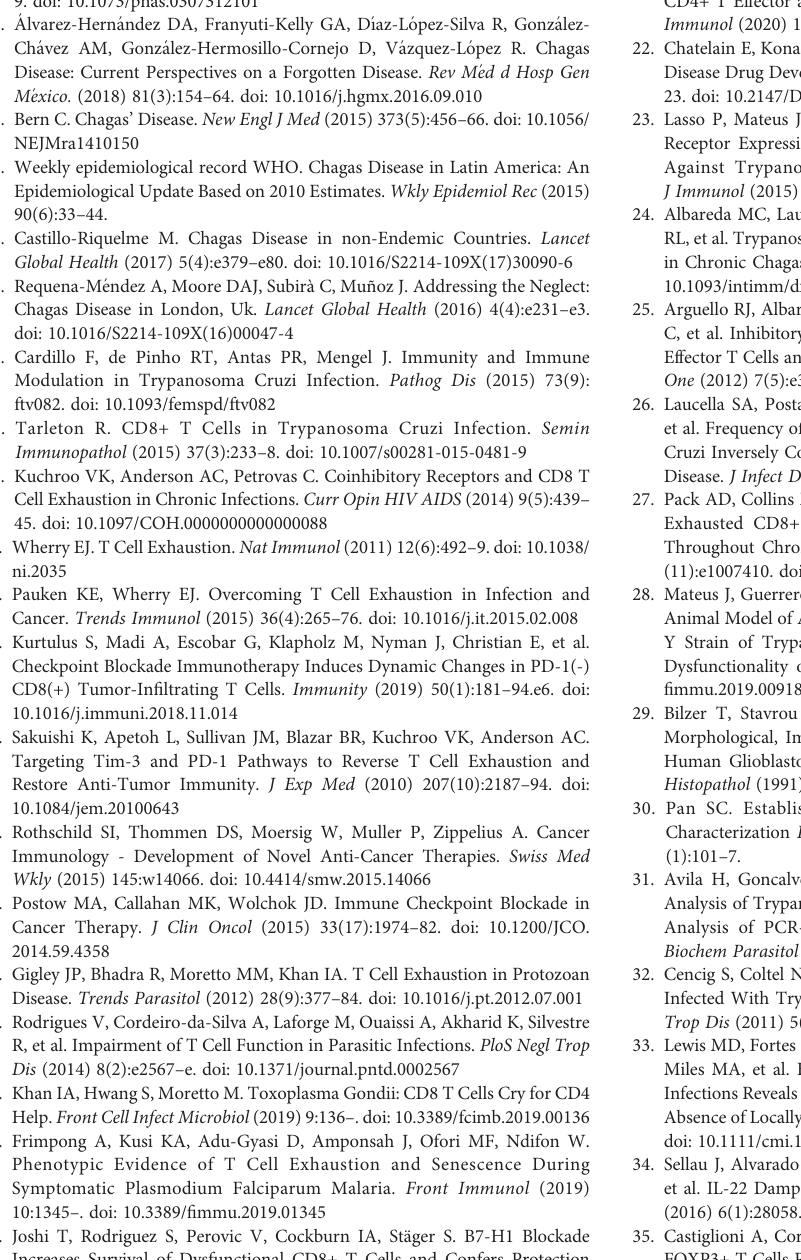
APC. (A) Gating strategy of not infected splenocytes from CD45.1 mice used as antigen-presenting cells (highlighted in orange). (B) PD-1 and TOX gating on infected cells in CD45.1 + cells and their capability to produce IFN- g . (C) Gating strategy for infected muscle cells from CD45.2 mice, de fi ned as “ effector cells ” (highlighted in blue). (D) Representative plot of the PD-1 and TOX co-expression gated on CD44 + CD8 + T cells. (E) Comparison of the capability to produce IFN- g , TNF- a andGrBbetweenPD-1 + TOX + andPD-1 - TOX - Tcells. (F) FMOcontrolswere used to set the gates for CD44, PD-1 and